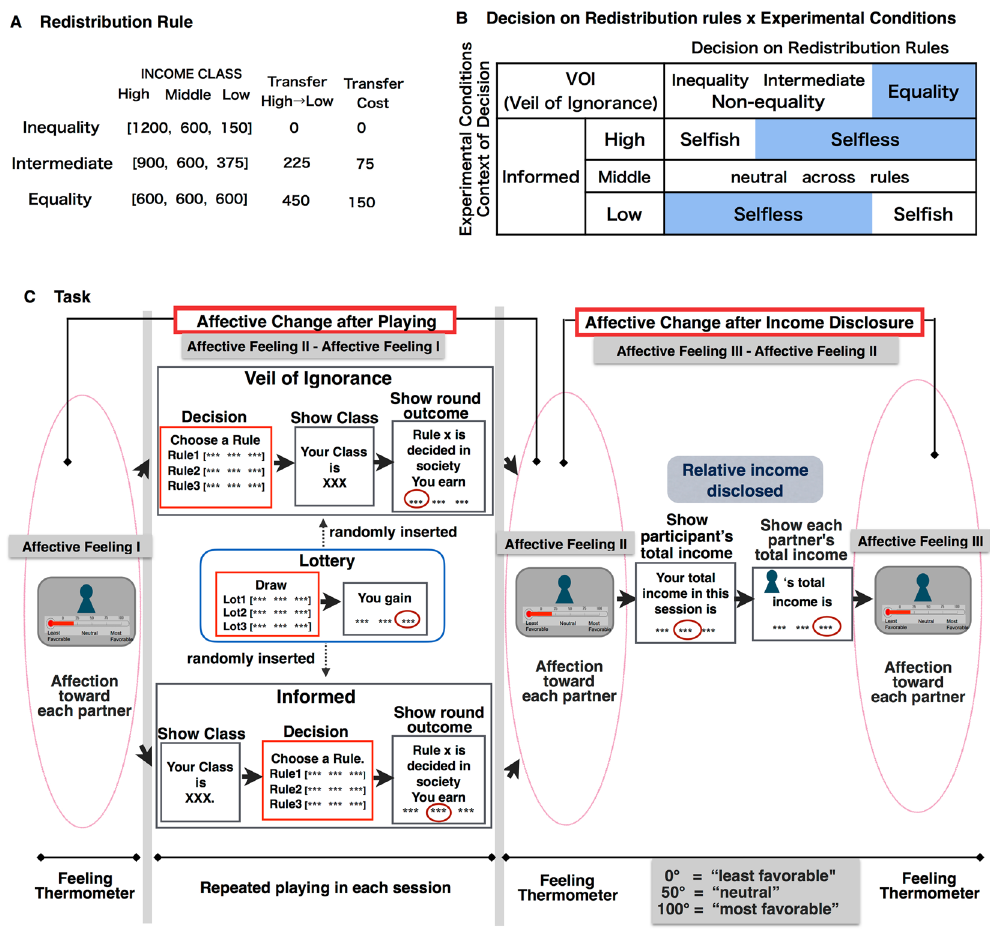
Figure 1. Experimental Design. ( A ) Each participant was required to choose one of three redistribution rules: preserving the status quo of inequality, advancing intermediate redistribution, or achieving absolute equality. A total of 25% of the transferred income was lost as a cost. The equality rule incurred the largest cost, whereas the inequality rule was cost-free. During the games, these rules were termed Rules 1, 2, and 3, respectively, to avoid generating a decision bias. ( B ) When making a decision behind the VoI, class did not matter; thus, the rule was chosen in terms of equality. When the classes were “informed”, the experimental conditions were distinguished in terms of high-, middle-, and low-income classes. Therefore, we distinguished the decisions as an equality or non-equality decision in the VoI and a selfless or selfish decision in high- and low-income classes, whereas decisions were neutral in the middle class. ( C ) On repeated runs of each session (the Informed and VoI conditions), the participant chose a rule (red-boxed screen) and was shown the payoff that corresponded to her assigned class along with the rule chosen at the society level. Earnings from each round accumulated to a total income that was revealed at the end of game. Participants were told that the total income determined the payment for completion of the experiment. Before and after playing each session, participants were shown a photo of each partner and were asked to rate how much they (dis)liked each partner on a thermometric scale, i.e., a feeling thermometer (Affective Feeling I and II, respectively). The change in affection after playing was calculated by subtracting Affective Feeling I from Affective Feeling II. Next, we disclosed their own and their partners’ incomes over the entire session and asked the participant to again rate their feelings for their partners. We subtracted the rating immediately after playing (Affective Feeling II) from that after the disclosure of income (Affective Feeling III) and used it as a measure, namely, the change in affection after income disclosure. The relative income was calculated by dividing the participants’ total income by the partners’ income. In each session, a lottery game with the same format was randomly inserted. The redistribution-specific activation was calculated by subtracting the activation evident when drawing the lottery from that observed upon a redistributive